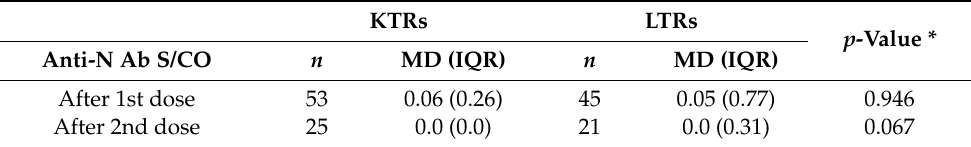
Table A4. The results of anti-SARS-CoV-2 nucleocapsid protein Ab assays in all patients regardless of con-firmed